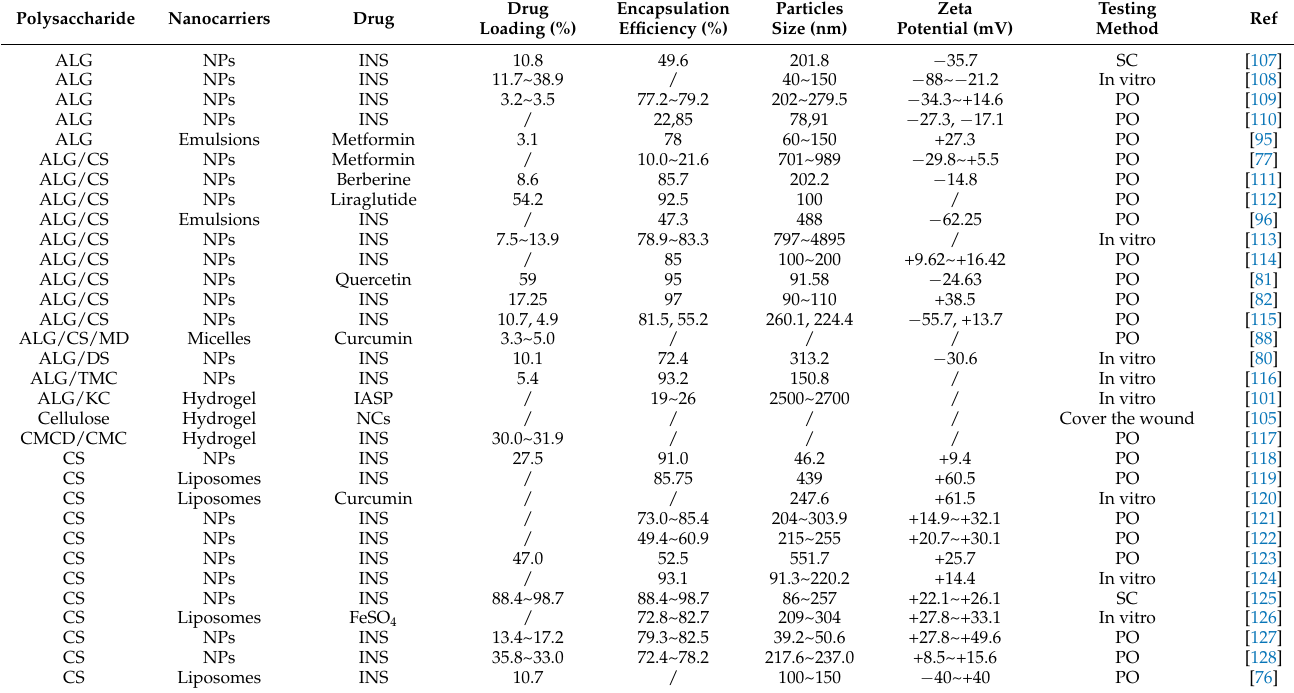
Table 1. Polysaccharide-based nanocarriers for the entrapment of drugs and used against diabetes.